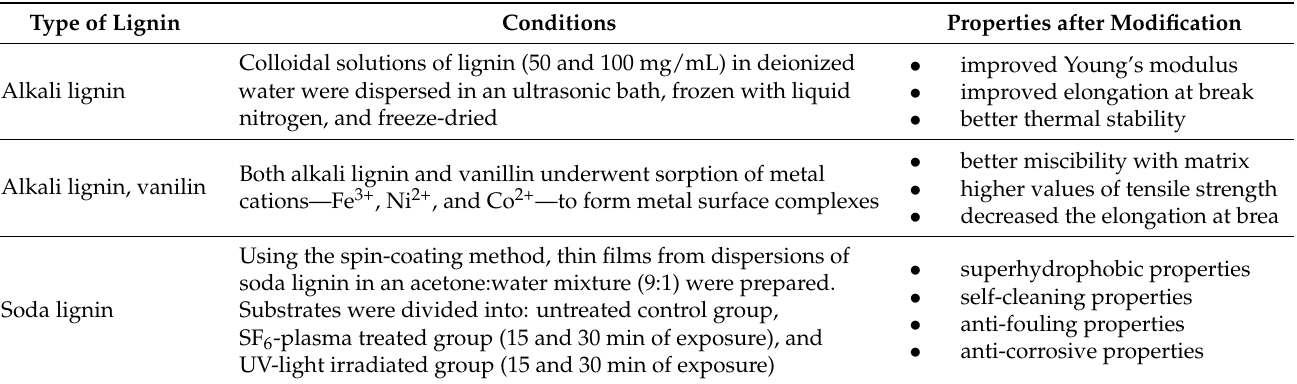
Table 12. Table summarizing physical modification processes of lignin. Type of